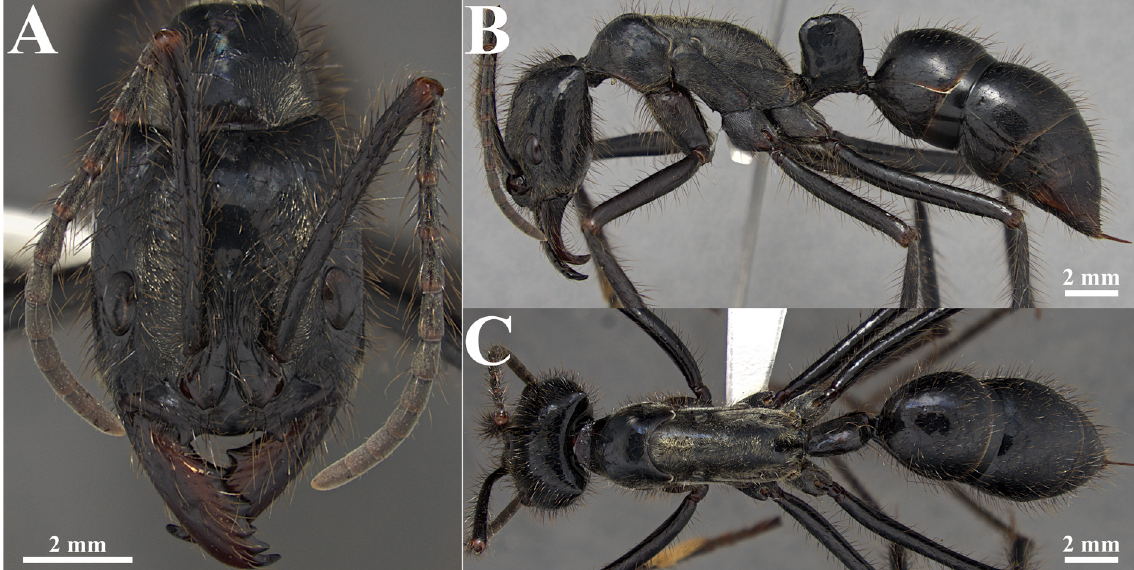
(specimen from Parauapebas, Pará, ☿